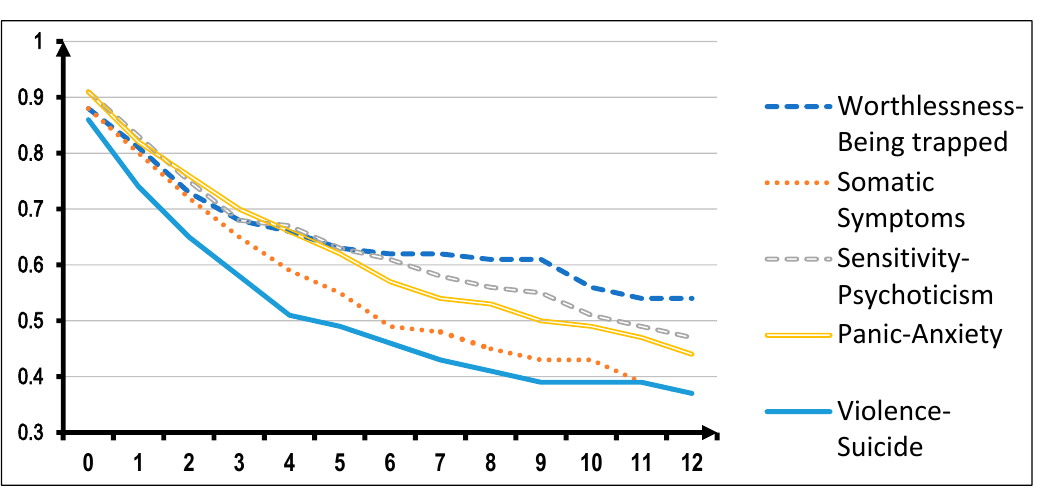
Figure 3. Survival in treatment of 2122 TC-treated patients according to the prominent psychopathology and independently of principal substance of abuse (Wilcoxon statistics = 17.69, DF = 4; p = 0.001).